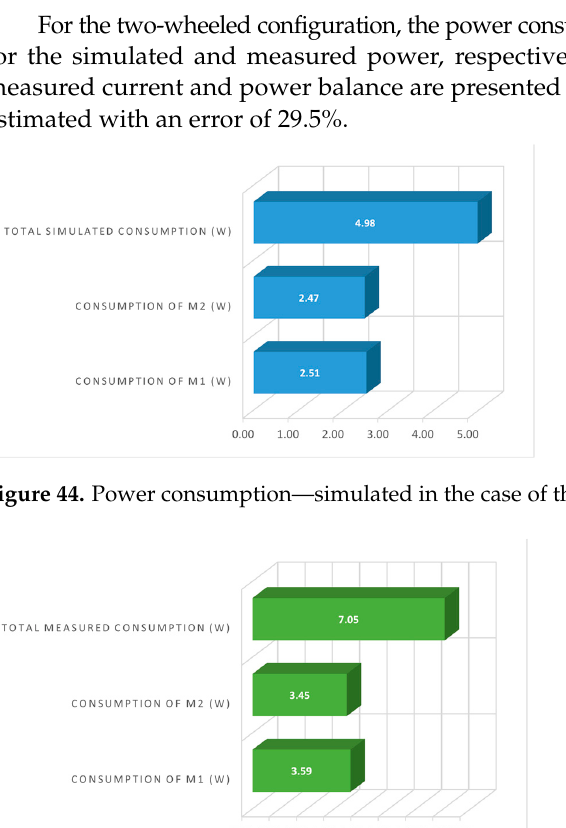
Figure 45. Power consumption—measured in the case of the two-wheeled robot. Table 13. Current and power consumption values of the motors and the entire mobile robot with two drive wheels.